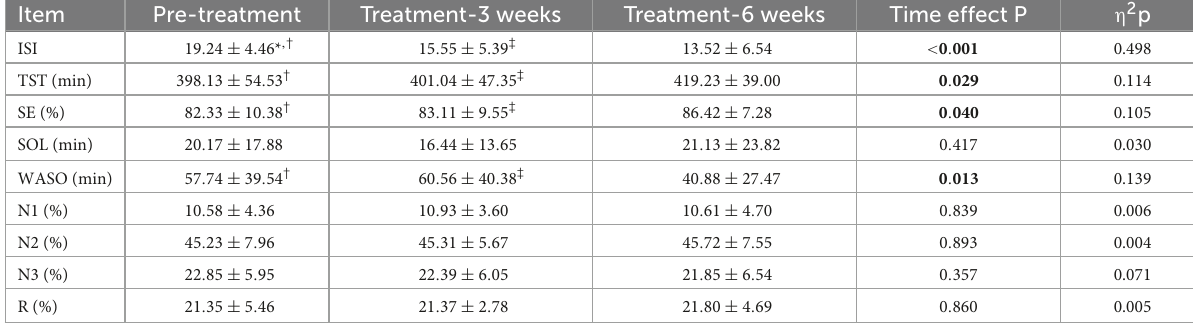
TABLE 1 Self-reported insomnia severity and objective nighttime sleep characteristics before and after electrostatic therapy. Item